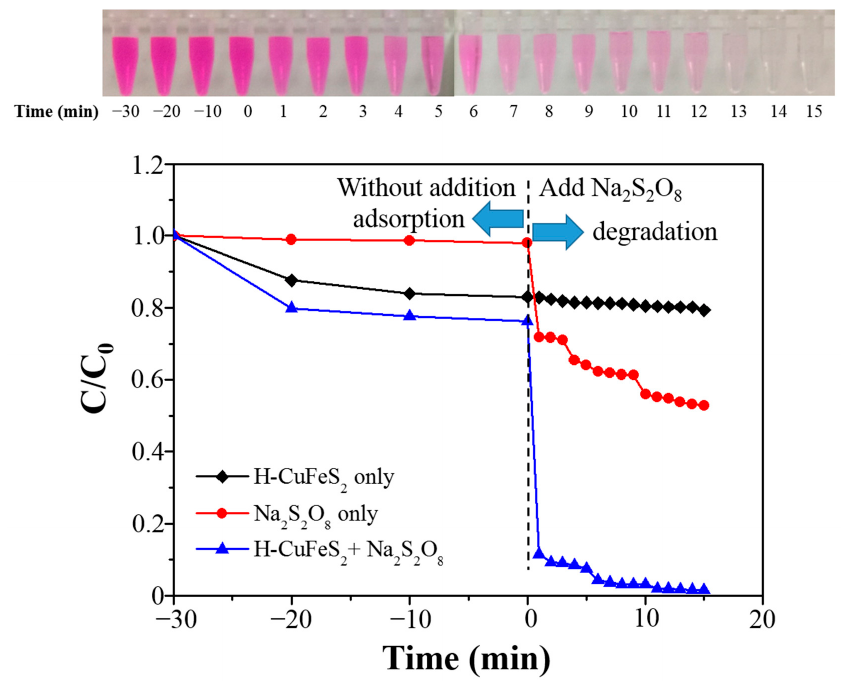
Figure 9. Fenton-like reaction for RhB degradation under different conditions: H-CuFeS 2 samples only (black), Na 2 S 2 O 8 only (red), and H-CuFeS 2 in the presence of Na 2 S 2 O 8 (blue). Top image: photographs of the RhB solution under the Fenton reaction at different reaction time.